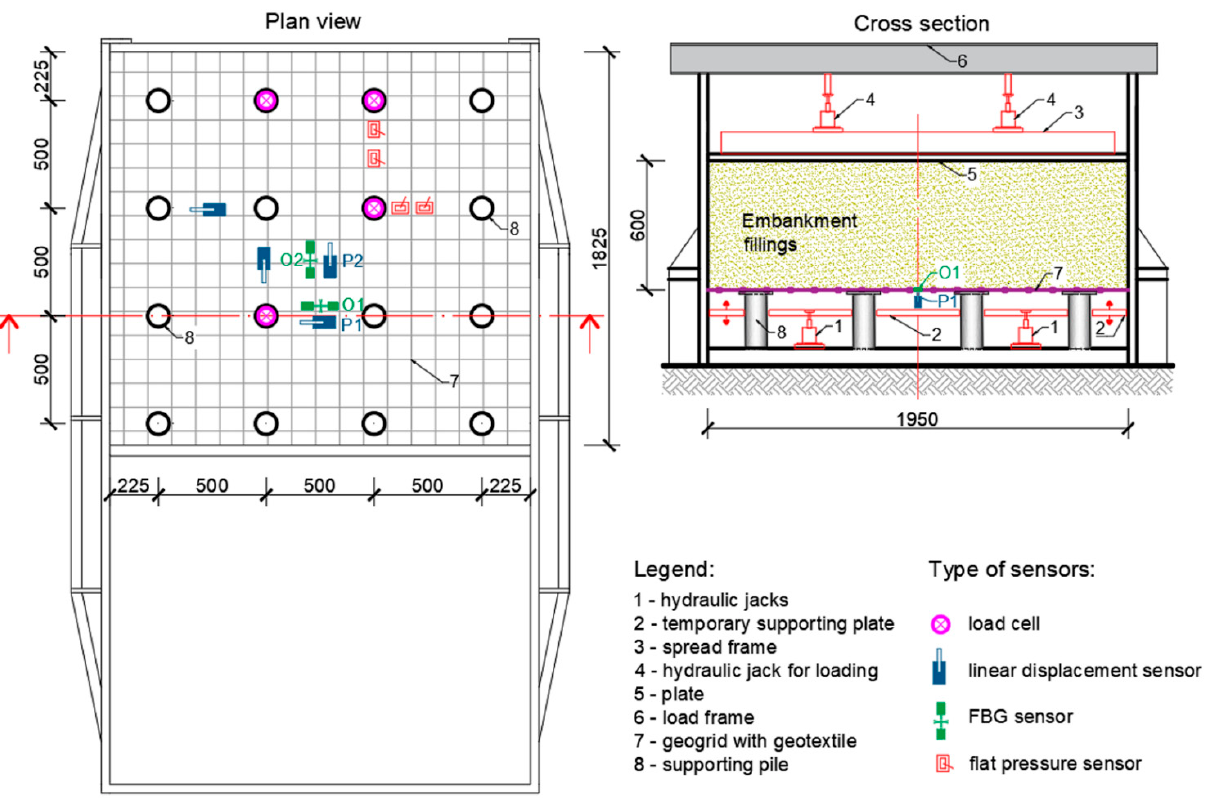
Figure 8. Scheme of the physical model of the piled embankment (units mm) with used sensors.